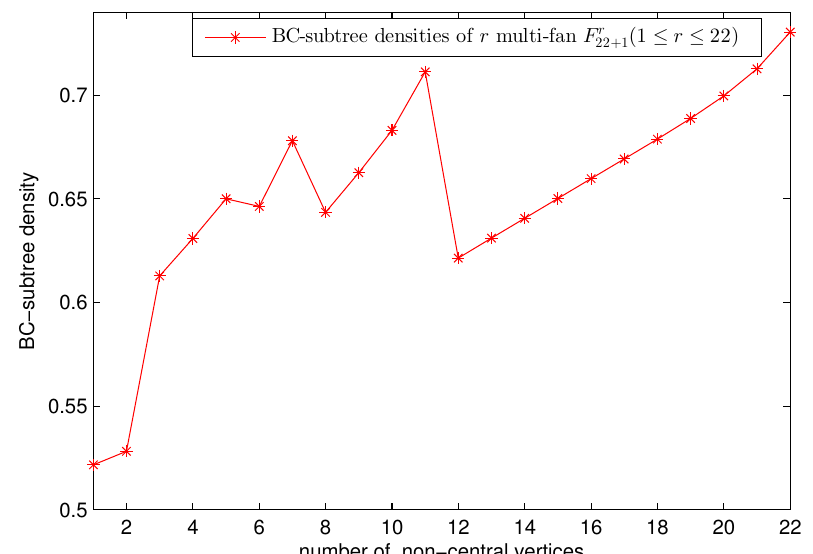
Figure 5. BC-subtree densities of r multi-fan F r Table 2. Data related to BC-subtrees of F r